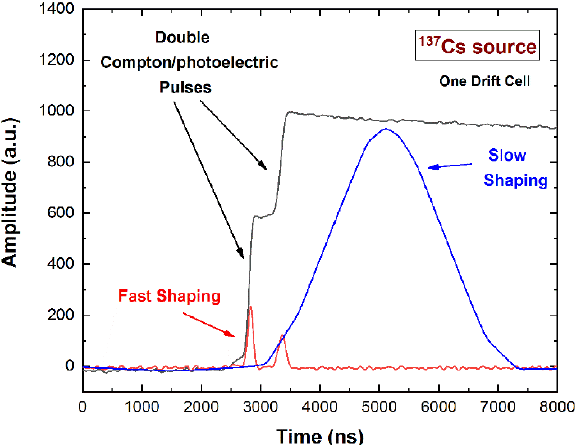
Figure 4. Double pulses (black line) generated on a single drift cell from Compton/photoelectric interactions. The shaped pulse (blue line) from a standard slow shaping (pulse time with of about 4 µ s), optimized and used to analyze single photoelectric pulses, gives rise to a false single pulse. While, the shaped pulses (red line) from a fast shaping (pulse time with of about 200 ns) really highlight the presence of the double pulses. The digital electronics allow, for each detector pulse, the analysis with both fast and slow shaping, implemented in pipeline.